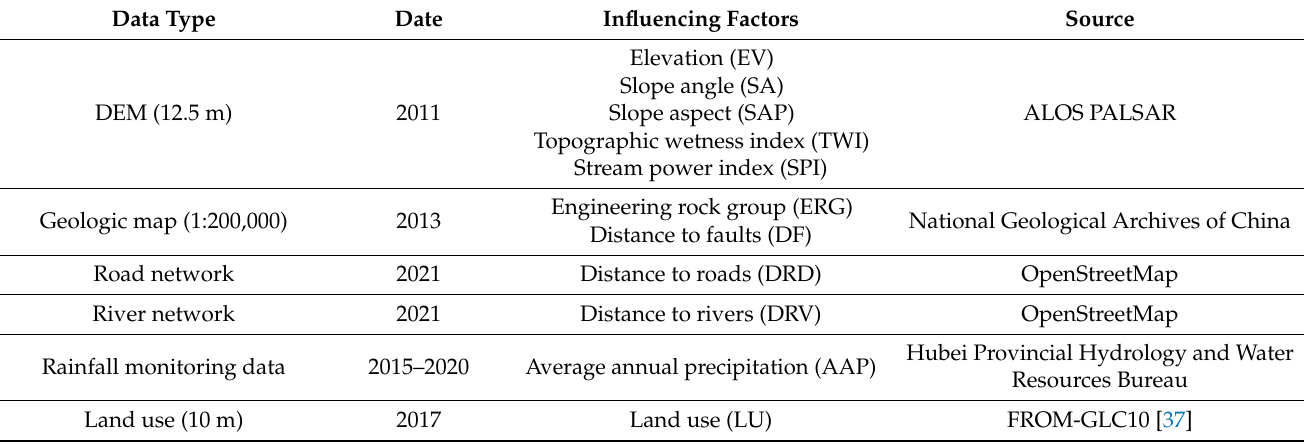
Table 1. Multisource landslide influencing